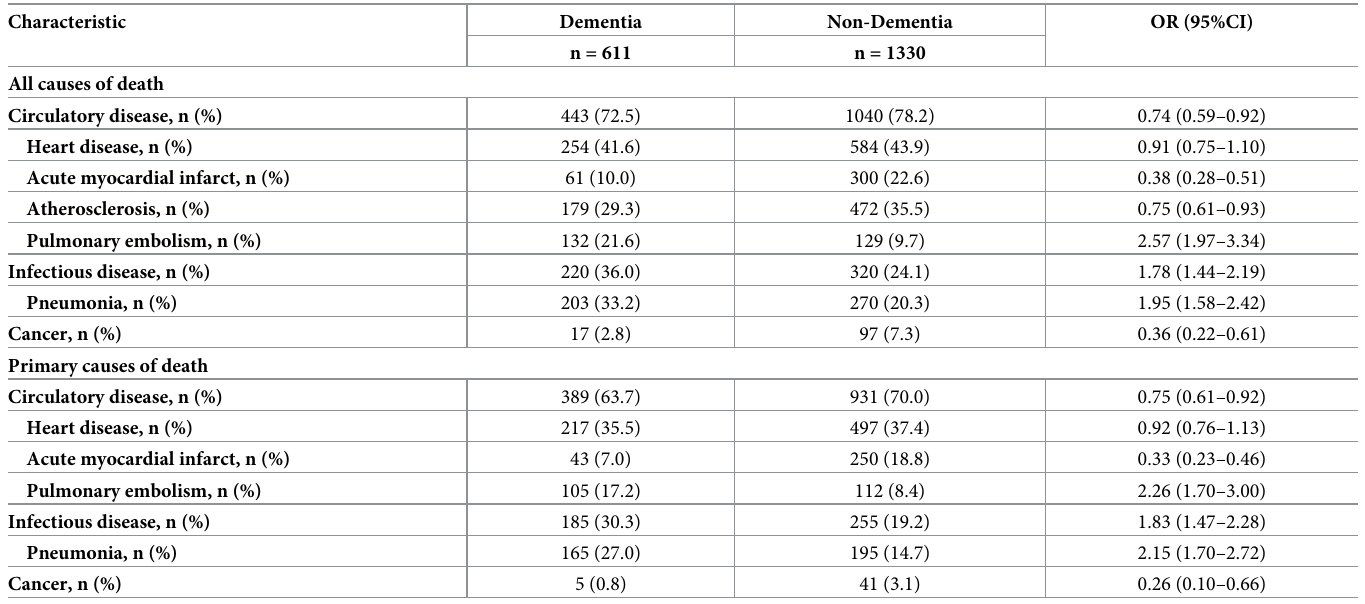
Table 2. Unadjusted logistic regression models for the association of dementia and causes of death, OR (95%CI),